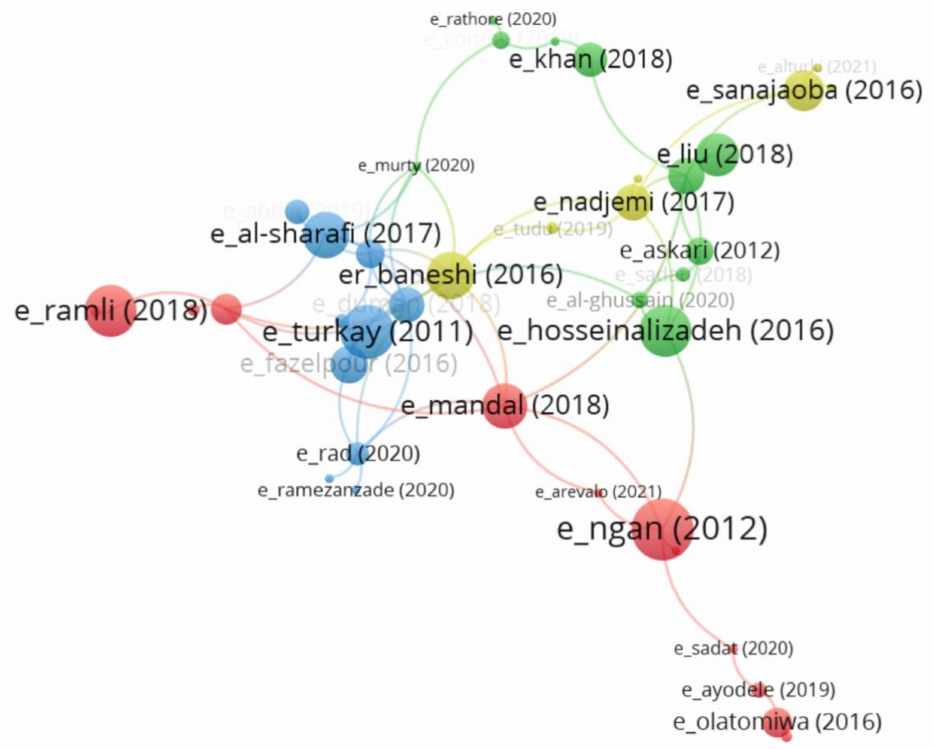
Figure 7. Citation map with the connected publications in Figure